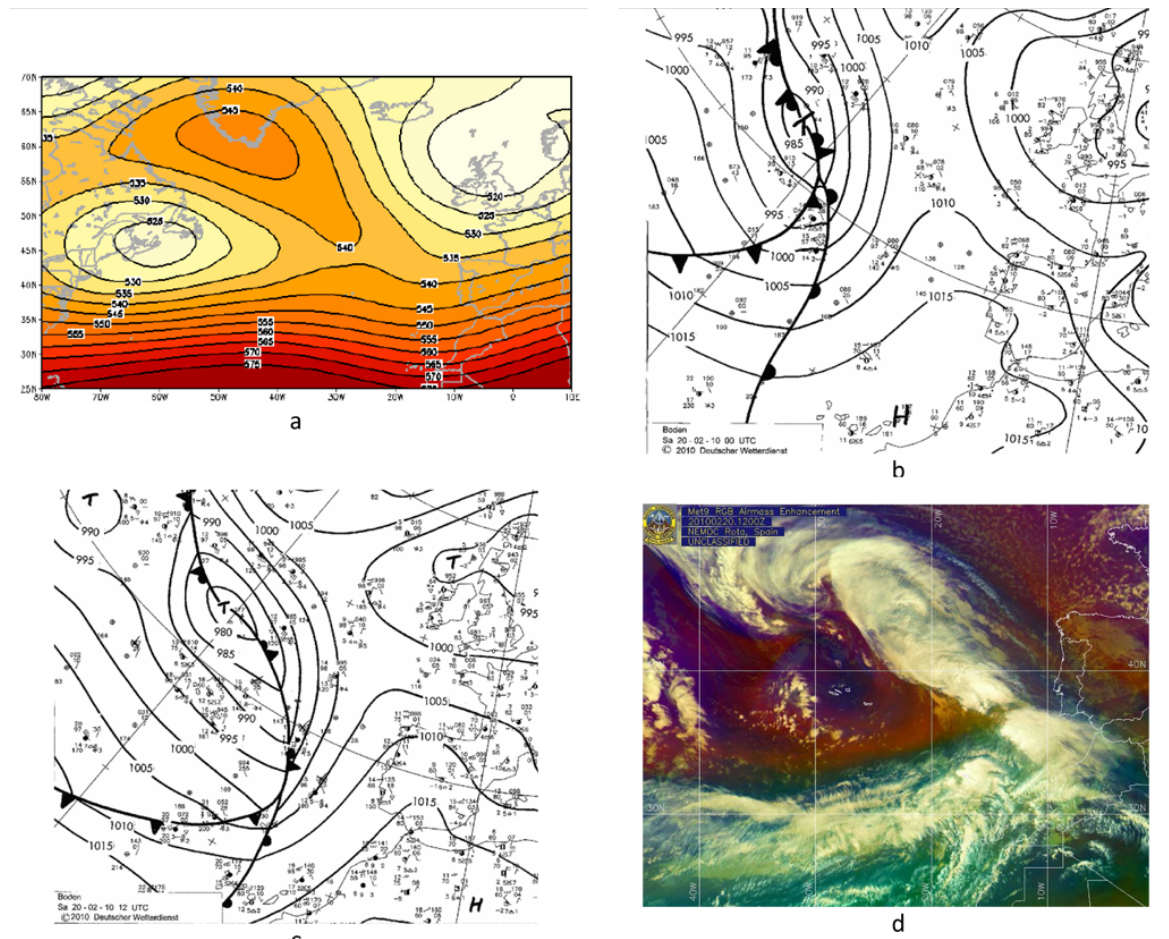
Fig. 6. (a) Geopotential height field 500hPa for 15–21 February 2010; (b) surface chart 20 February 2010, 00:00UTC (c) same as (b) but for 12:00UTC (d) Met9 satellite figure, 12:00UTC. Sources: (a) Era-interim (b–c) DWD (d) Naval European Meteorology and Oceanographic Center